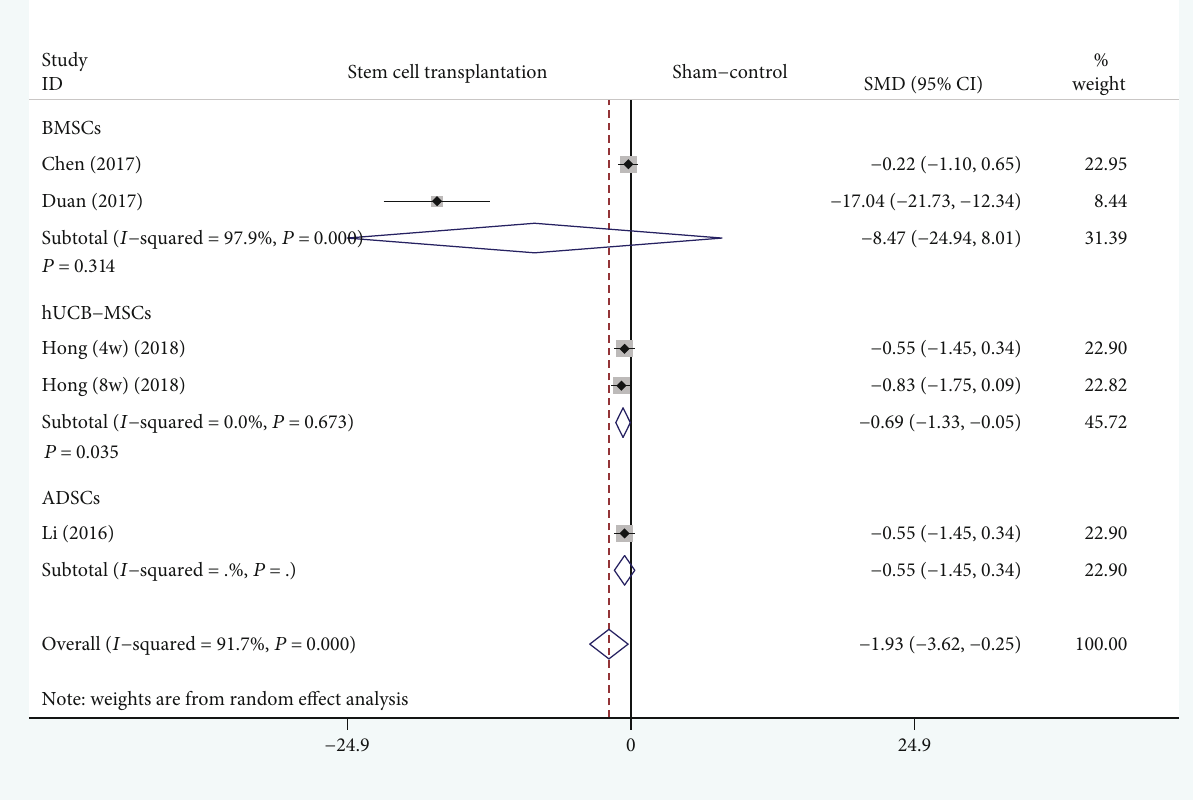
Figure 6: Forest plot showing the e ff ect of stem cell treatment group compared with sham operation group on BV/TV. BV/TV: bone volume/total volume; BMSCs: bone marrow mesenchymal stem cells; hUCB-MSCs: human umbilical cord blood-derived mesenchymal stem cells; ADSCs: adipose-derived stem